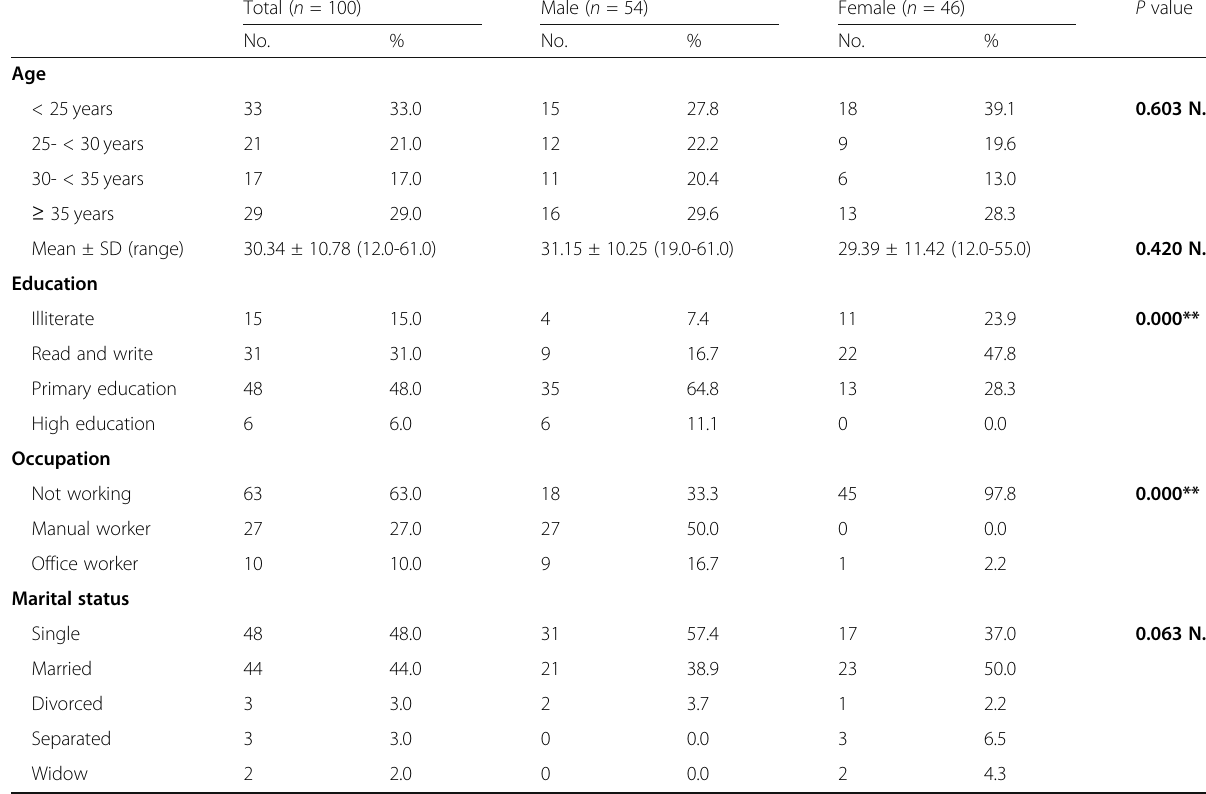
Table 1 Demographic characteristics of the studied